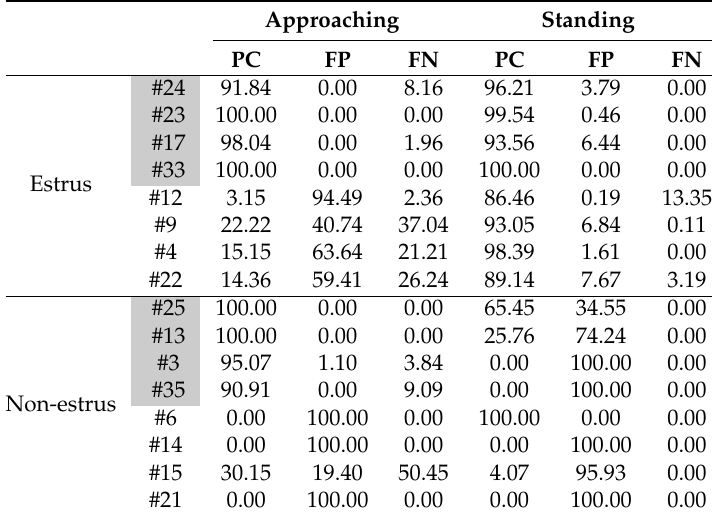
Table 2. PCs, false positives, and false negative of estimation using random forest. Gray-colored cells represent goats used for training